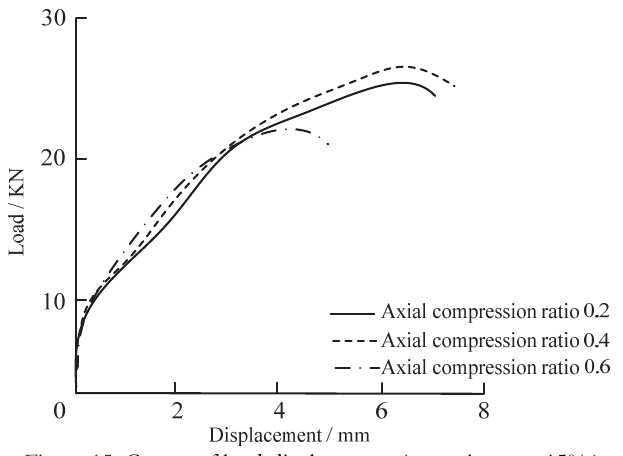
Figure 15: Curves of load-displacement (corrosion rate 15%